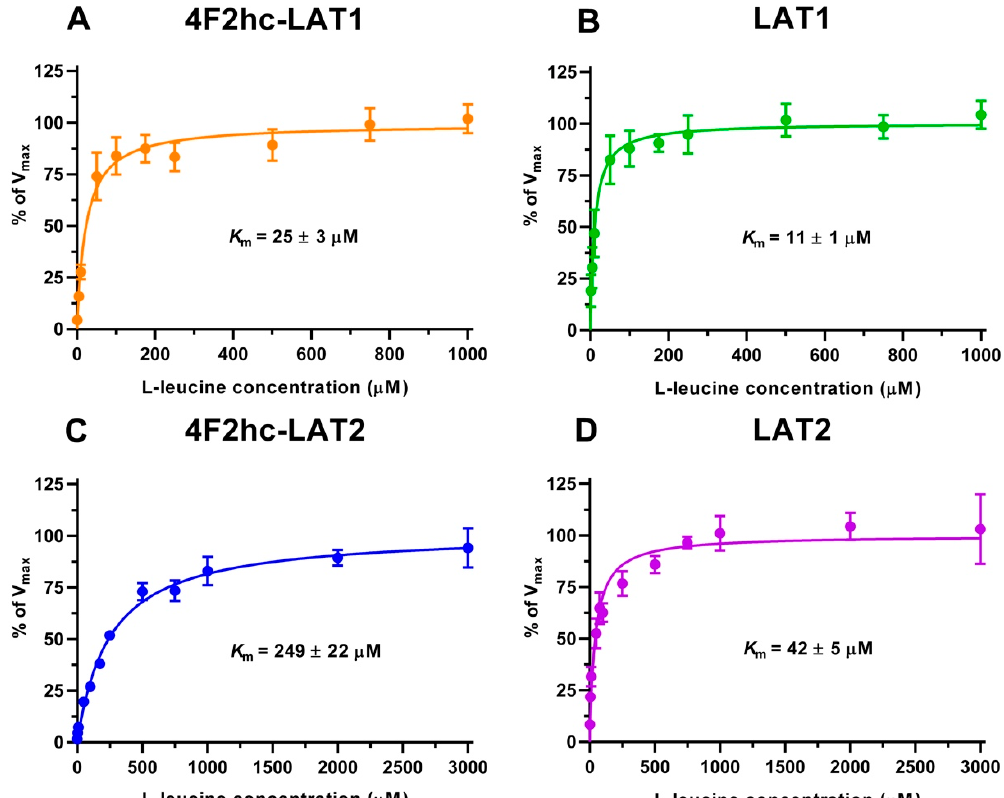
Figure 2. Kinetic analysis of [ 3 H]L-leucine uptake into P. pastoris KM71H cells expressing 4F2hc-LAT1 (( A ); orange), LAT1 (( B ); green), 4F2hc-LAT2 (( C ); blue) or LAT2 (( D ); violet). Data points represent means with SD of at least nine [ 3 H]L-leucine uptake replicates from three independent experiments normalized to V max (100%). K m values were obtained by fitting a Michaelis–Menten kinetics model curve to data points.